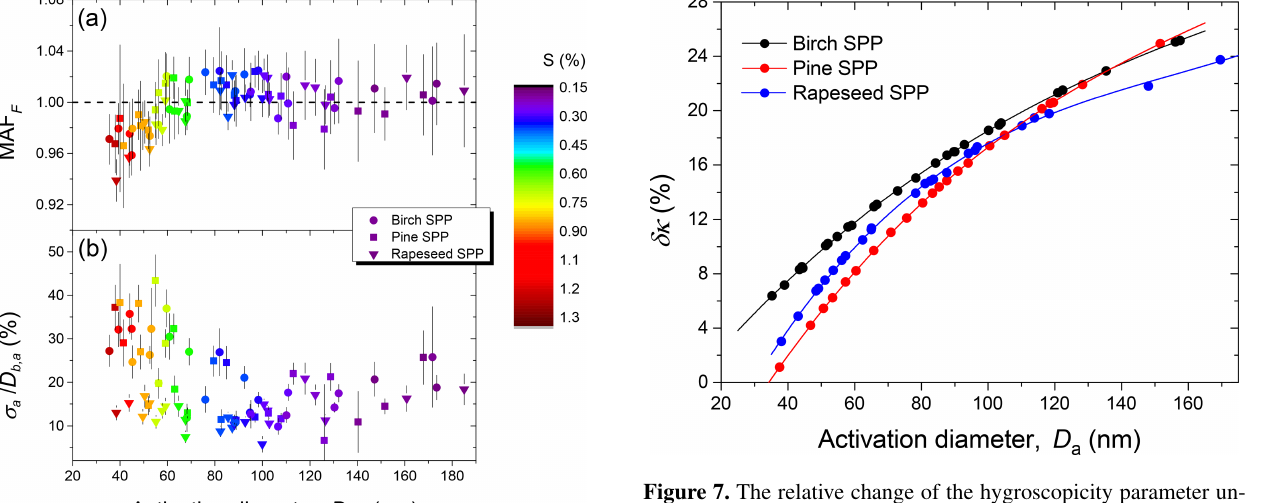
Figure 7. The relative change of the hygroscopicity parameter un- certainty, δκ , due to particle irregular structure as a function of acti- vation diameters, D a . Lines are third-order polynomial fits to guide the